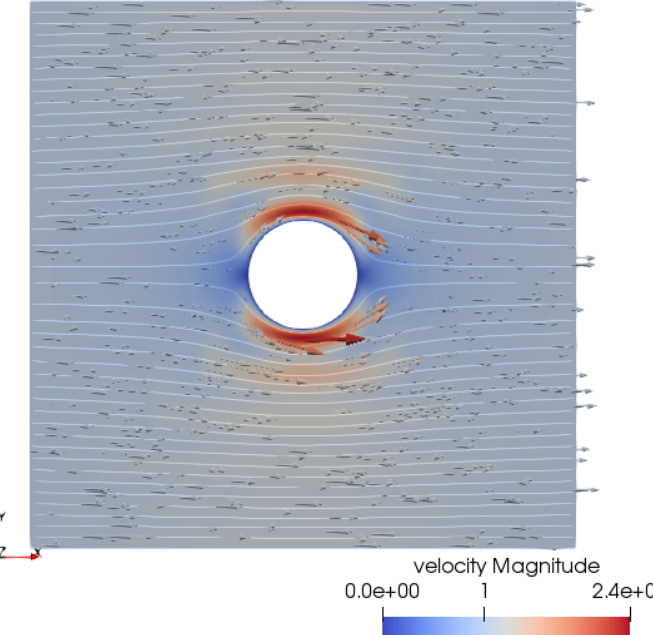
Figure 8. Case 1: the velocity representation with stream